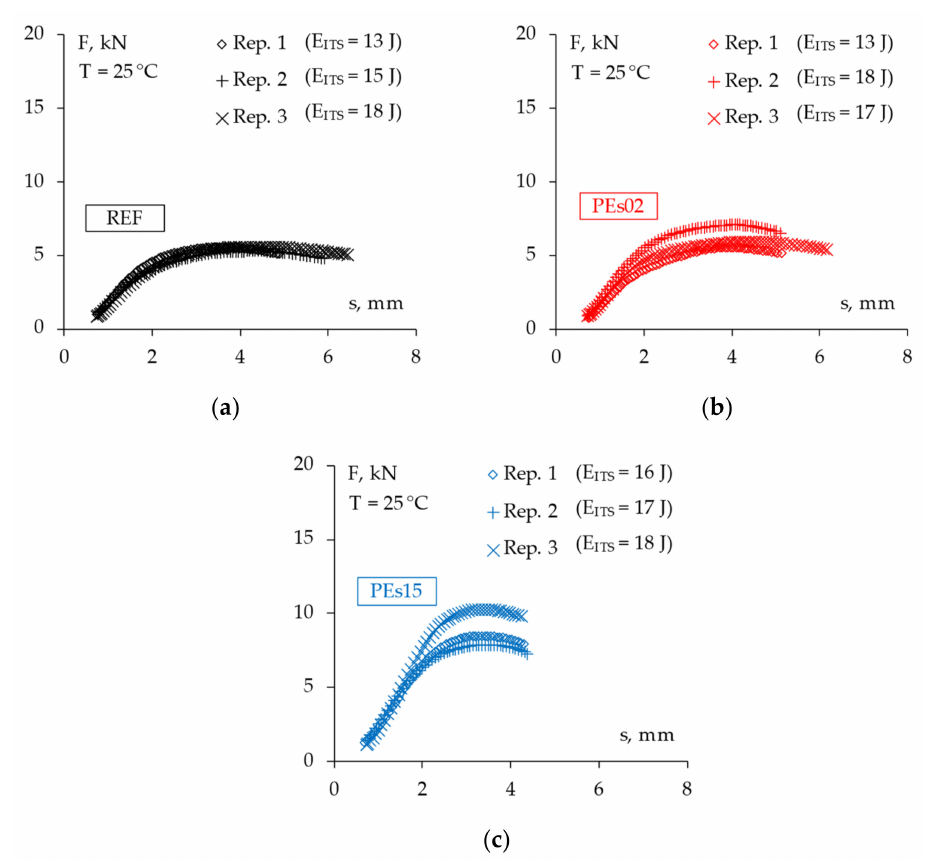
Figure 15. The force–displacement trend from the ITS tests for all mixtures: ( a ) REF; ( b ) PEs02; ( c ) PEs15.